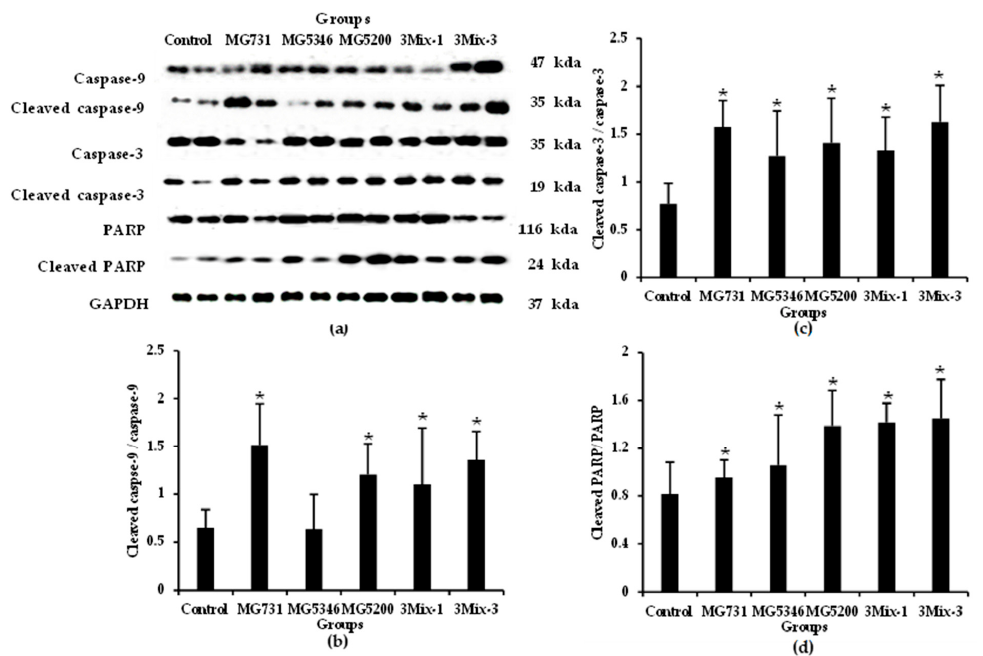
Figure 5. Expression of apoptosis-related proteins in tumor tissues from xenograft model analyzed by Western blotting assay. After 19 days of heat-killed single or mixed strain treatment, proteins were extracted from the tumor tissues and subjected to Western blotting. ( a ) The representative Western blot images; Western blot quantitative data of ( b ) cleaved caspase-9/caspase-9, ( c ) cleaved caspase-3/caspase-3, and ( d ) cleaved PARP/PARP. Results are presented as the mean ± SD ( n = 6). * p < 0.05 compared with the control group. We confirmed the expression of apoptotic signaling molecules in tumor tissues de- rived from the xenograft models. Caspase-9, an initiator caspase, initiates apoptosis signal transduction, and caspase-3 and PARP, executive caspases, perform bulk proteolysis to induce apoptosis [26]. The expression of cleaved caspase-9 was significantly higher in tu- mor tissues derived from the MG731, MG5200, and 3Mix-3 groups than in the control group. (Figure 5a,b). Compared with the control group, the MG731 and 3Mix-3 groups increased by 2.30- and 2.09-fold, respectively. The expression level of cleaved caspase-3 was increased by more than 1.5-fold in the experimental group compared with the control group and was the highest in the MG731 and 3Mix-3 groups (Figure 5a–c). The expression level of cleaved PARP increased in all treatment groups compared with that in the control group, and the 3Mix-3 group showed the highest increase (Figure 5a–d). Using IHC staining, we confirmed the increase in the expression levels of p-Akt, p53, Bax, cleaved caspase-9 and -3, and PARP in the tumor tissues derived from MKN1 cell- implanted xenograft mice that were orally administered a mixture of B. bifidum MG731, L. reuteri MG5346, L. rhamnosus MG5200, or a mixture of B. bifidum MG731, L. reuteri MG5346, and L. rhamnosus MG5200 compared with the others (Figure 6).